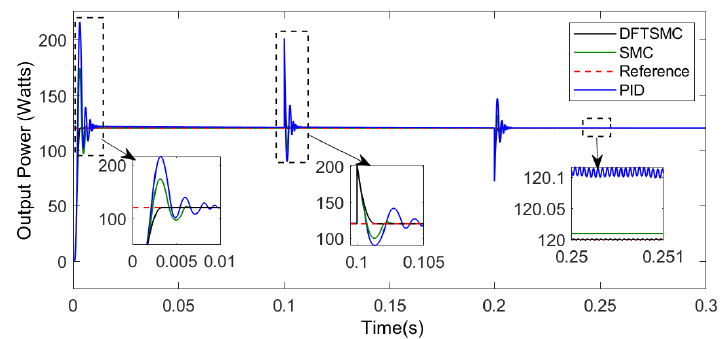
Figure 16. Regulation of output Power, P out , during perturbation in R L